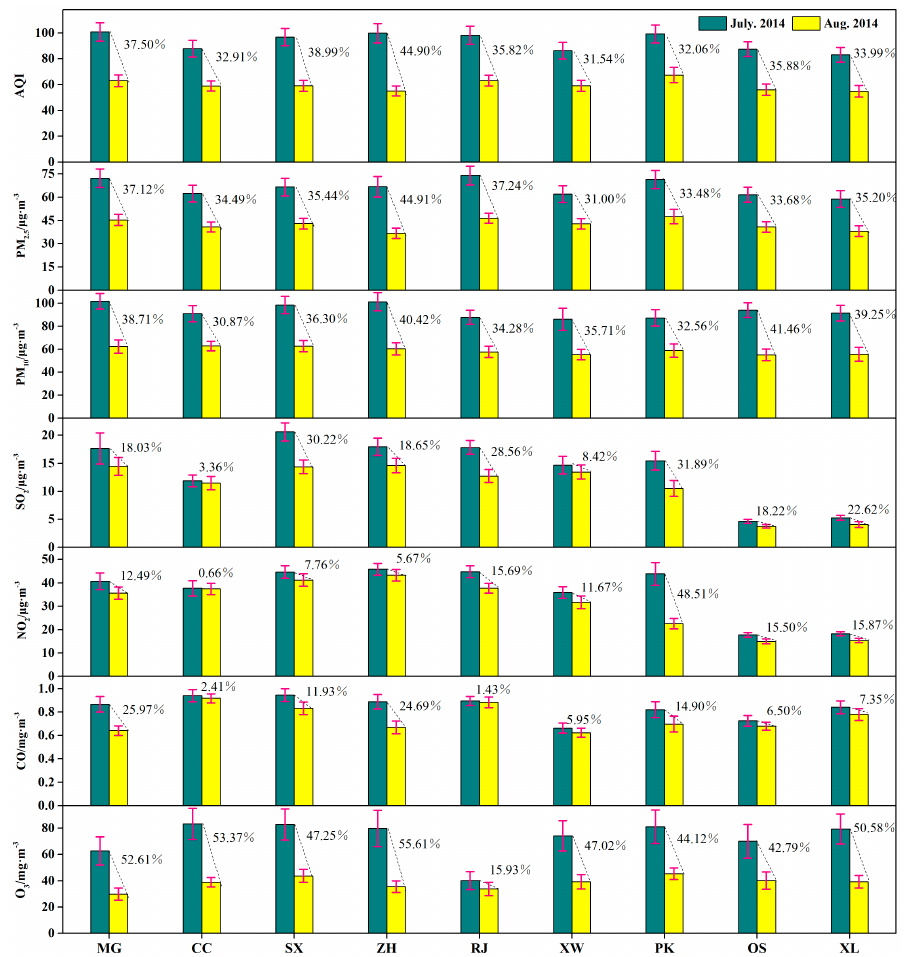
Figure 4. Spatial variation of the AQI and air pollutants at each site before and during the emission reduction.